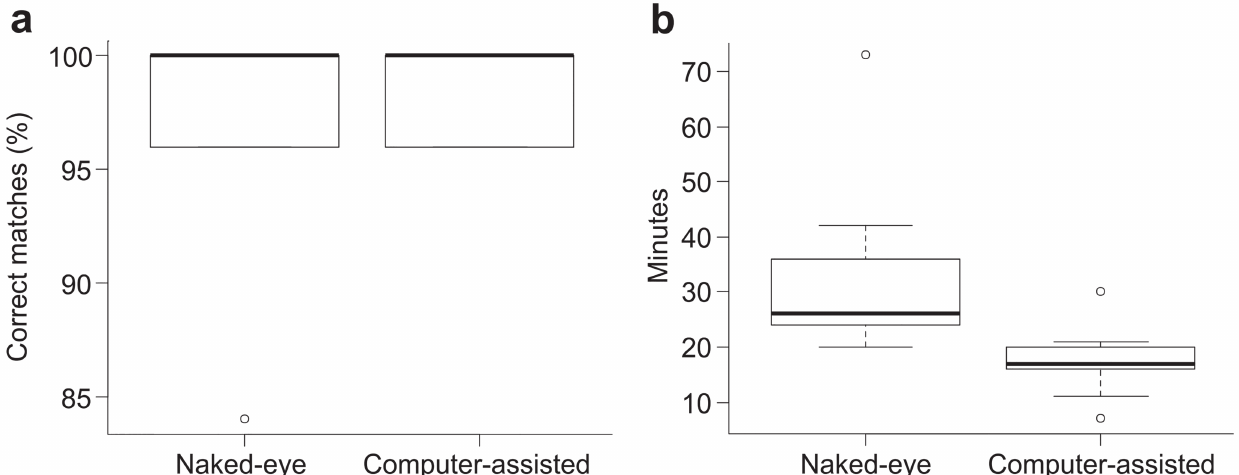
Fig. 4. Percentage of correct matches (a) and expended minutes (b) between naked-eye and computer-assisted field test photo-identification for individual recognition of Rineloricaria aequalicuspis (n = 9). Boxplots show median (central thicker line), first and third quartile (box limits), 95% confidence interval of median (whiskers), and